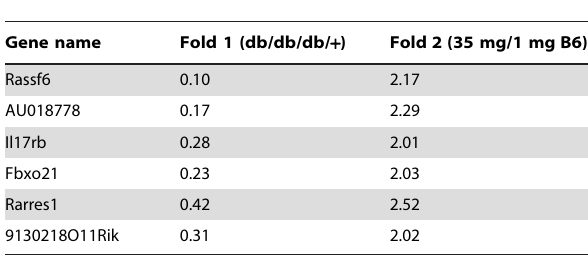
DNA microarray analysis was repeated with the Cy3 and Cy5 dyes reversed (a dye swap). Fold change ( Fold 1 ) represents the average of mRNA expression level in db/db mice relative to db/ + mice. Fold change ( Fold 2 ) represents the average of mRNA expression level in mice with a 35 mg PN HCl/kg diet relative to a 1 mg PN HCl/kg diet.